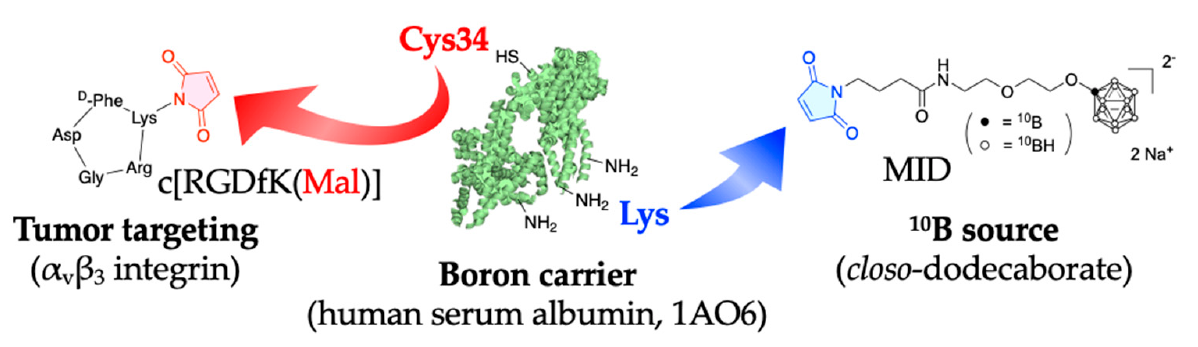
Figure A1. This figure shows the chemical structure and synthetic schema of cRGD-MID-AC. Table A1. Cellular uptake of boron in F98 glioma cells incubated with 10 µg B/mL of each boron carrier.